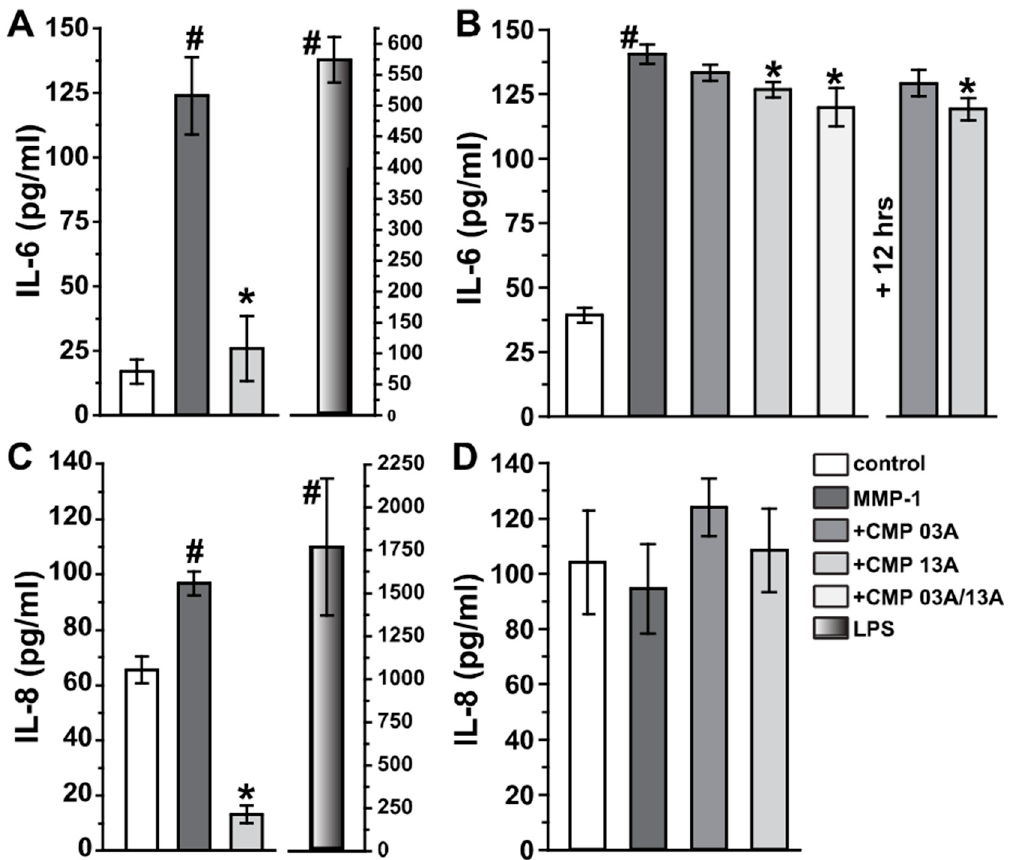
Figure 5. CMP treatment reduces ARPE-19 inflammatory signaling: ELISA measurements. ( A ) In- terleukin-6 (IL-6) secretion from ARPE-19 cells increased significantly following treatment with ac- tivated MMP-1 (60 nM) for 6 h compared to intact collagen control (#, p < 0.001). Following a com- plete exchange of media, cells were treated with 200 µM CMP 13A, which reduced Il-6 by 5-fold (*, p = 0.007) to control levels ( p = 0.99). Right: positive control using lipopolysaccharide (LPS, 10 mg/mL) shows +30-fold increase compared to control ( p <0.001). ( B ) Left: IL-6 secretion increased significantly following 24 h of 20 nM MMP-1 (#, p < 0.001). Concurrent treatment with CMP 13A significantly reduced Il-6 compared to MMP-1 ( p = 0.005), as did a combination of CMP 13A and 03A ( p = 0.014, concentration of each was 200 µM). Right: adding 200 µM CMP 13A at the 12 h mark for the remaining 12 h also reduced Il-6 compared to MMP-1 ( p = 0.001). ( C ) Interleukin-8 (IL-8) secretion from ARPE-19 cells also increased following MMP-1(6 h, 60 nM) compared to control (#, p